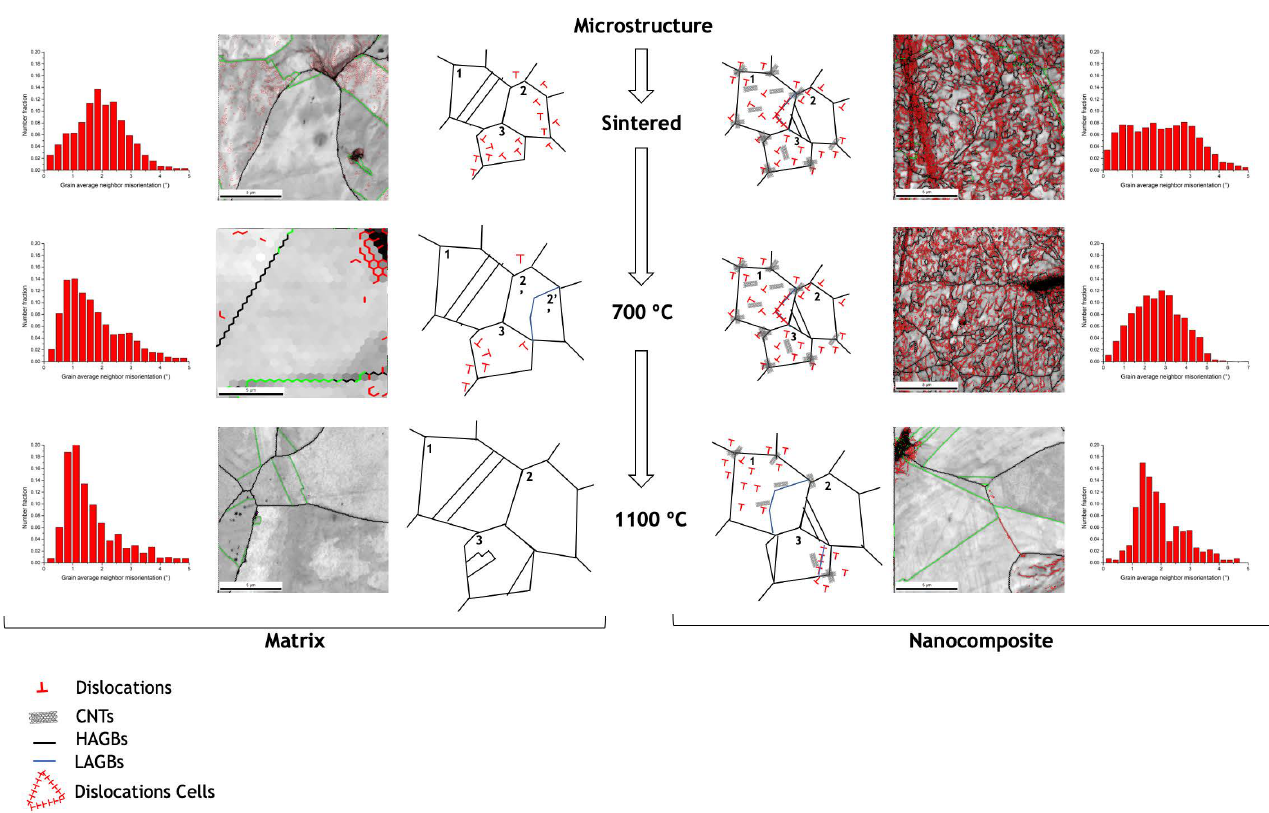
Figure 13. Grain average neighbor misorientation distribution; high magnification images present the microstructures with HAGBs, LAGBs and twins marked, and schematic representation of the matrix and nanocomposites showing the effect of the CNTs on the microstructural evolution of the nanocomposites during heat treatments (HAGBs and LAGBs: high- and low-angle grain boundaries, respectively).